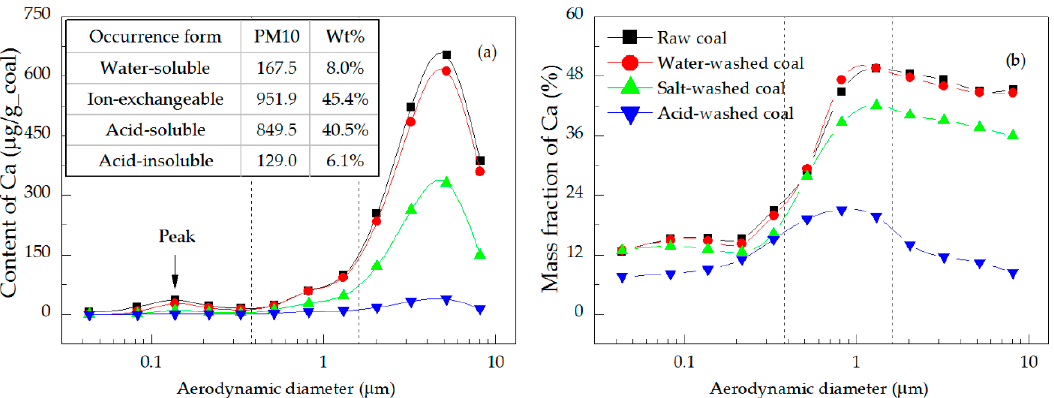
Figure 7. Distributions of the ( a ) content and ( b ) mass fraction of Ca in the PM. Figure 8. Distributions of the ( a ) content and ( b ) mass fraction of Fe in the PM.